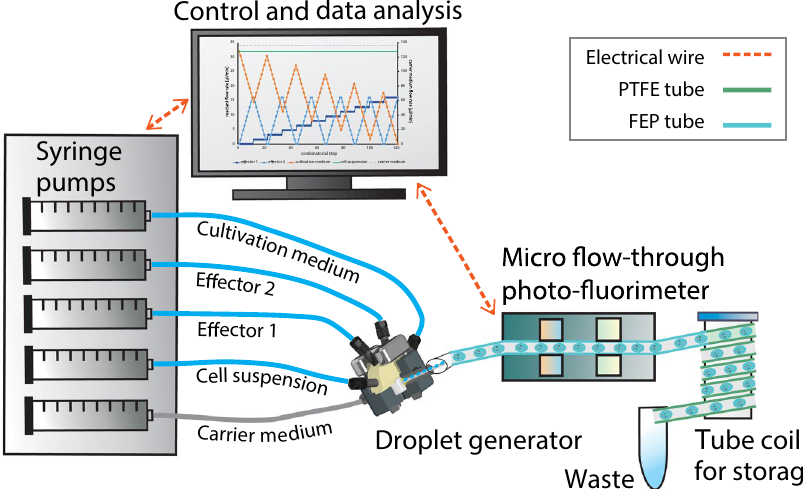
Figure 1. Experimental droplet-based microfluidic setup for 1D and 2D screening of cultivation parameters used in this study. The illustration on the left shows a 5-channel syringe pump and the droplet generator which generates the droplets. The individual aqueous cell medium droplets are separated by the immiscible carrier medium. Droplet size/volume, spacing and composition can be adjusted via the controlled flow rate program of the syringe pump. The generated droplets are measured by a combined photo-fluorimetric micro flow-through detector unit. The droplet sequences are then collected and incubated in PTFE tube coils in an internally illuminated